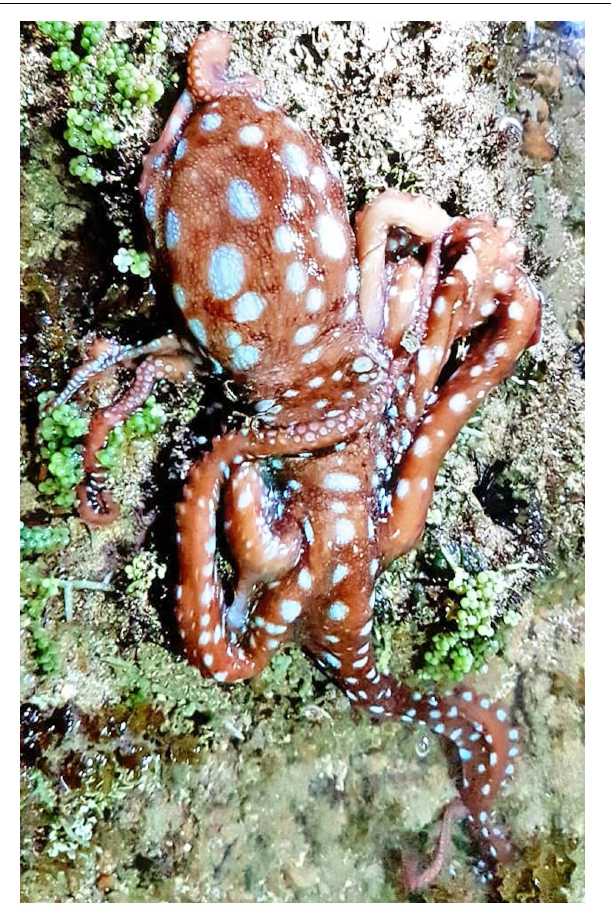
FIGURE 2 | “ Eastern octopus” ( Callistoctopus furvus Gould, 1852) found in the coastal reef of Cairu, Bahia, Brazil, photograph (Jesus et al.,